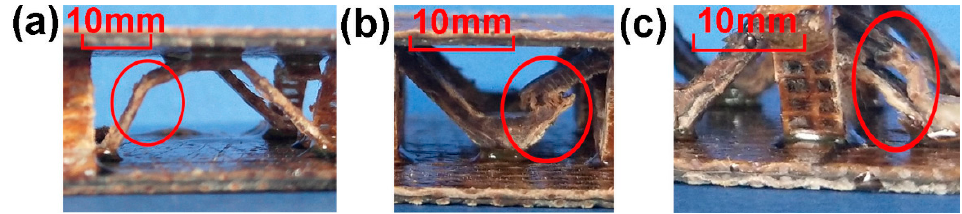
Figure 7. ( a ) Euler buckling of the struts ( b ) Fracture of the struts ( c ) Delamination failure of the